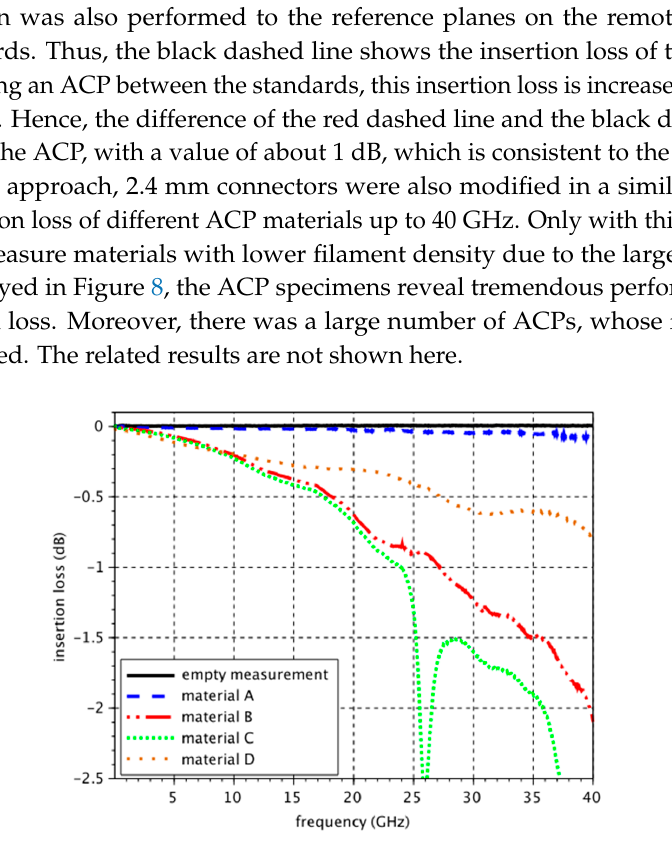
Figure 8. Insertion loss of different ACPs. (Reproduced with permission from [6], IEEE, 2017)